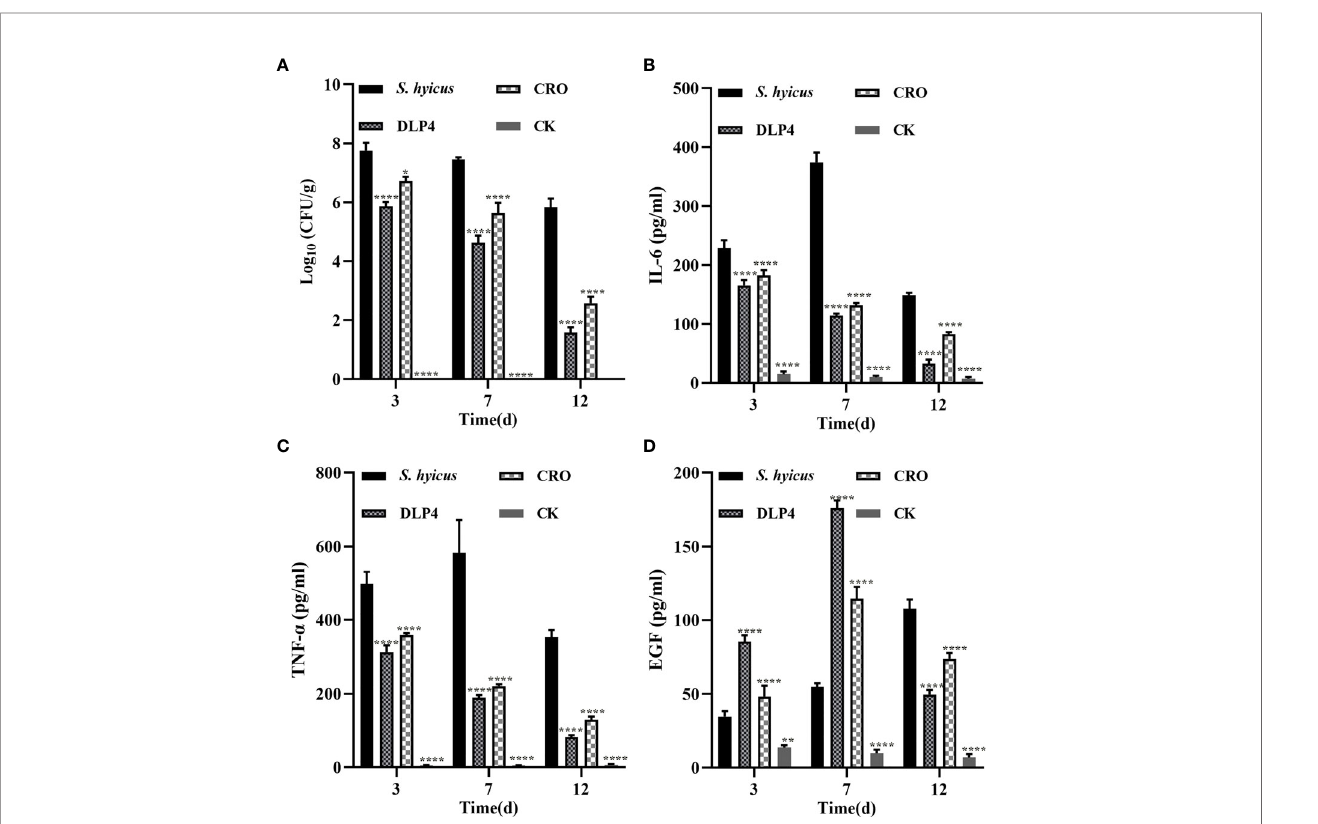
FIGURE 6 | The therapeutic effect of DLP4 in mouse model of cutaneous abscesses induced by S. hyicus ACCC 61734. (A) The effect of DLP4 or ceftriaxone (CRO) on bacterial burdens of cutaneous abscesses in S. hyicus -infected mice. Data are presented as mean ± SD. (B – D) The regulatory effect of DLP4 or CRO on in fl ammatory factors (B) TNF- a (C) IL-6 and (D) epidermal growth factor (EGF). All data were analyzed by the one-way ANOVA and Bonferroni multiple comparison. *p < 0.05, **p < 0.01, ****p <